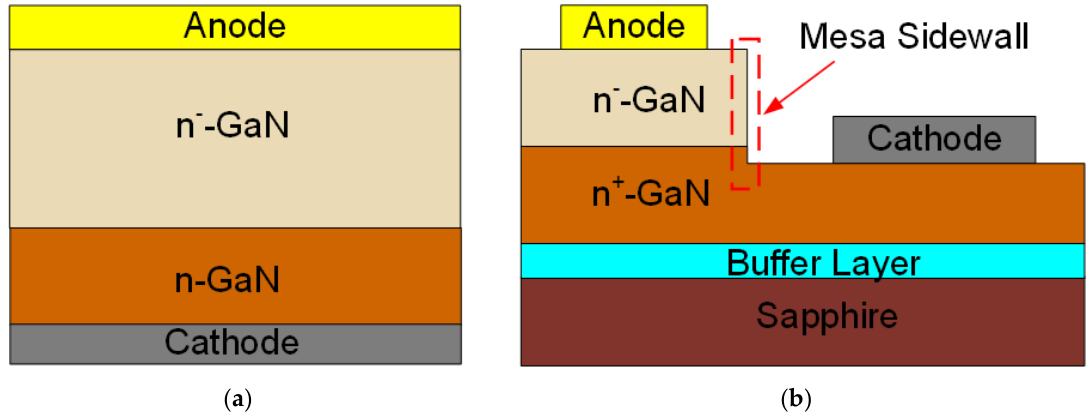
Figure 1. Schematic cross sections of ( a ) vertical gallium nitride (GaN) Schottky barrier diodes (SBDs) and ( b ) quasi-vertical GaN